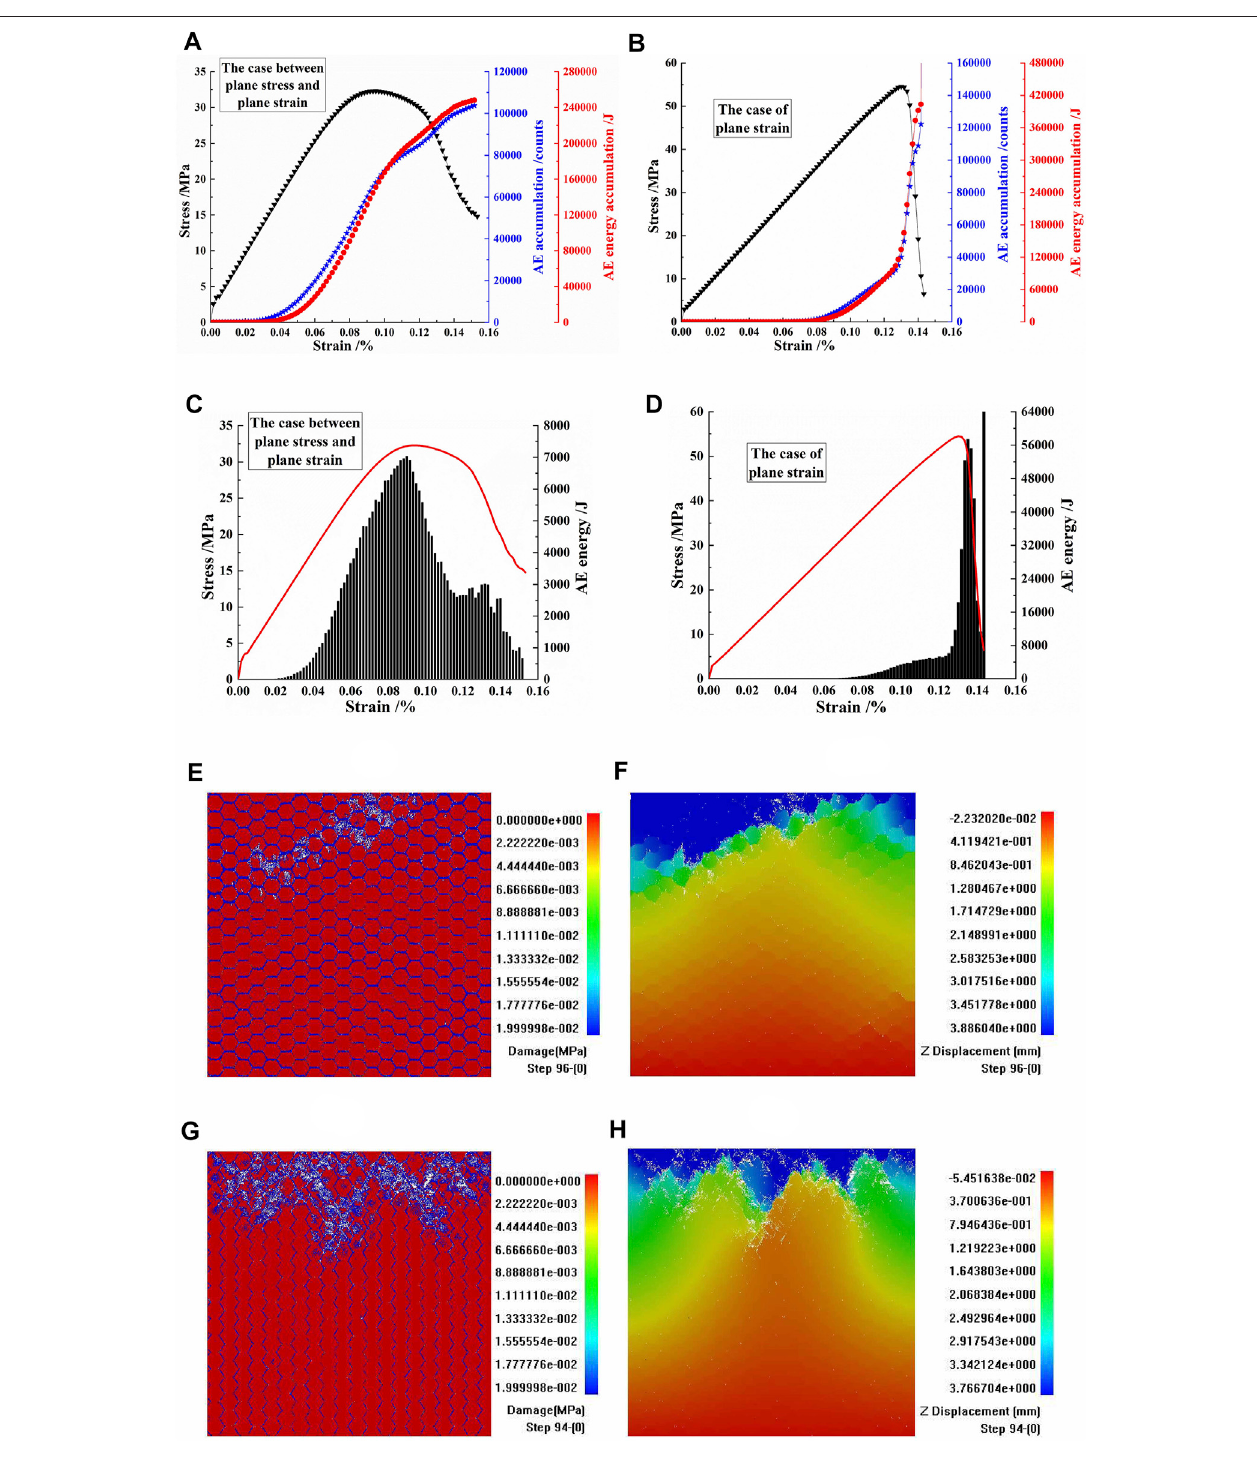
FIGURE 9 | (A,B) The stress – strain curves, acoustic emission (AE) accumulations, and AE energy accumulations of columnar jointed basalts (CJBs) in direction I orthogonaltothecolumnaxisforthecasebetweenplanestressandplanestrainandthecaseofplanestrain,withacon fi ningpressureof8 MPa. (C,D) Thestress – strain curves and AE energies of CJBs for the case between plane stress and plane strain and the case of plane strain. (E,F) Damage and displacement diagrams for the case between plane stress and plane strain. (G,H) Damage and displacement diagrams for the case of plane strain.